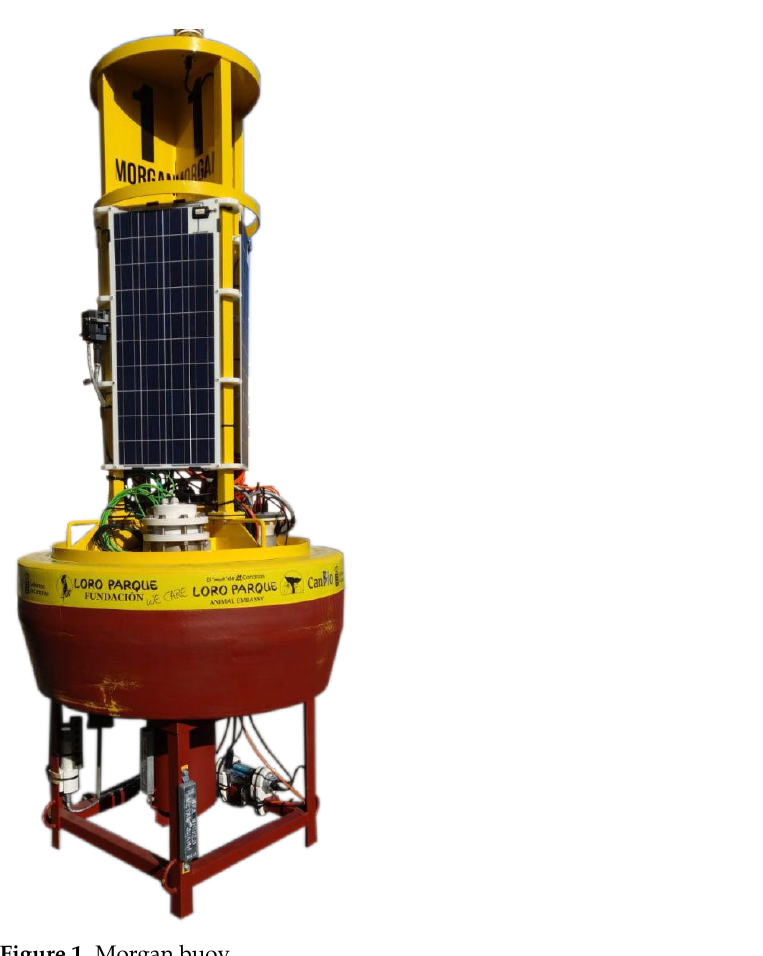
Figure 1. Morgan